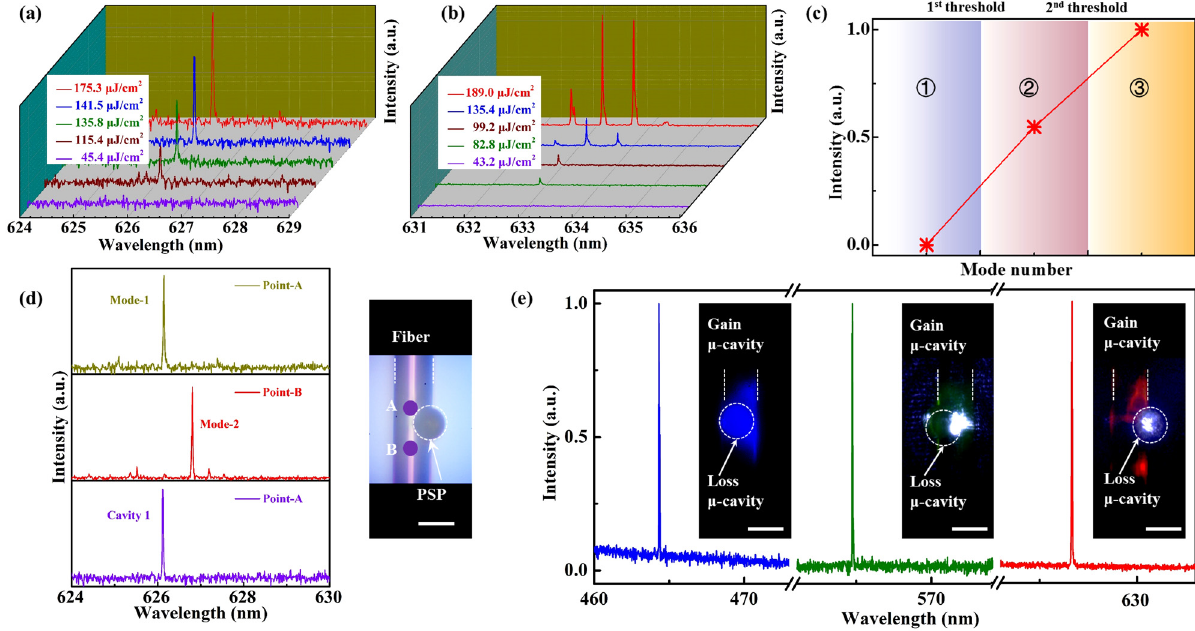
Figure 4: The optical characterization of polymer fiber and microspheres in a coupled μ -cavity. (a)Theevolutionofsinglemodelasinginthecoupled μ -cavity.(b)PLspectrumcollectedfromthecoupled μ -cavitywithdifferentpumpfluence. (c) The relationship between mode number and output intensity. These areas represent no lasing, single mode lasing and multi-mode lasing from left to right in the coupled μ -cavity, respectively. The first threshold and second threshold show the threshold of single mode lasing and multi-modelasing,respectively.Thenumber ① indicatestherangeofspontaneousemission, ② indicatestheoperatingrangeofsinglemode lasing, and ③ indicates the operating range of multimode lasing in the coupled μ -cavity, respectively. (d) The wavelength switch of single mode lasing can be realized by pump-controlled. (e) The normalized RGB single mode lasing and corresponding PL images. From left to right: the blue, green and red emissive. Scale bars are 100 μ